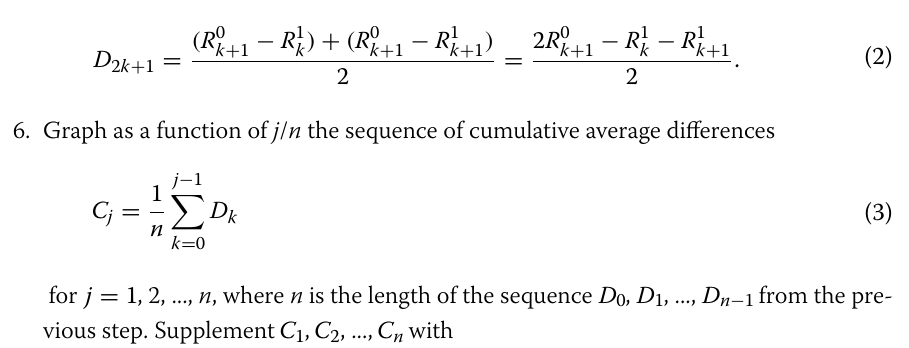
= 1 for j , 2, ..., n , where n is the length of the sequence D 0 , D 1 , ..., D n − 1 from the pre-